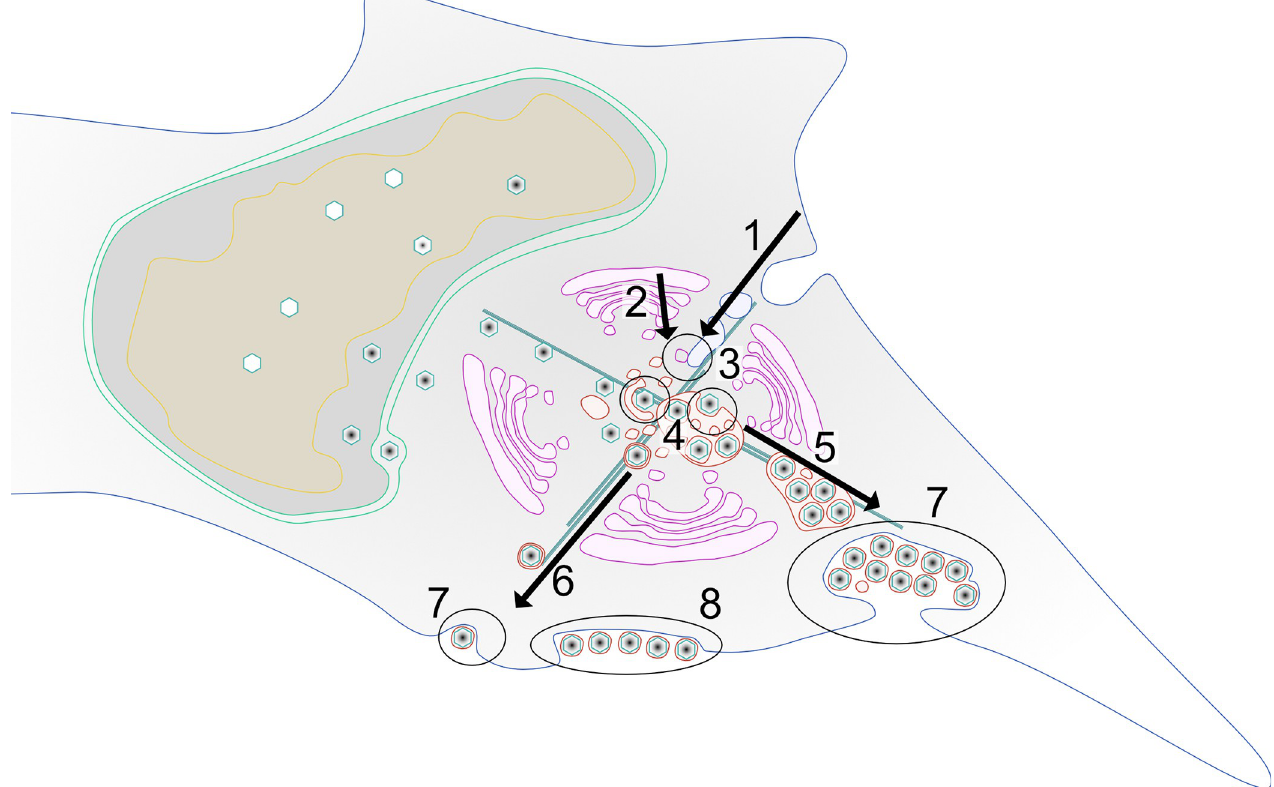
Fig 7. Model of possible HCMV release pathways. 1–3 Membranes of late-endosomal and trans-Golgi origin are trafficked to the center of the assembly complex and subsequently utilized for secondary envelopment. 4 After egress from the nucleus, capsids are trafficked to the assembly complex where they either bud individually into single vesicles or into MViBs to acquire their membrane envelope. 5–6 Virus-containing vesicles and MVBs are transported towards the plasma membrane, and 7 fuse with it to release their content to the extracellular space. 8 MViB fusion leads to EVA formation.